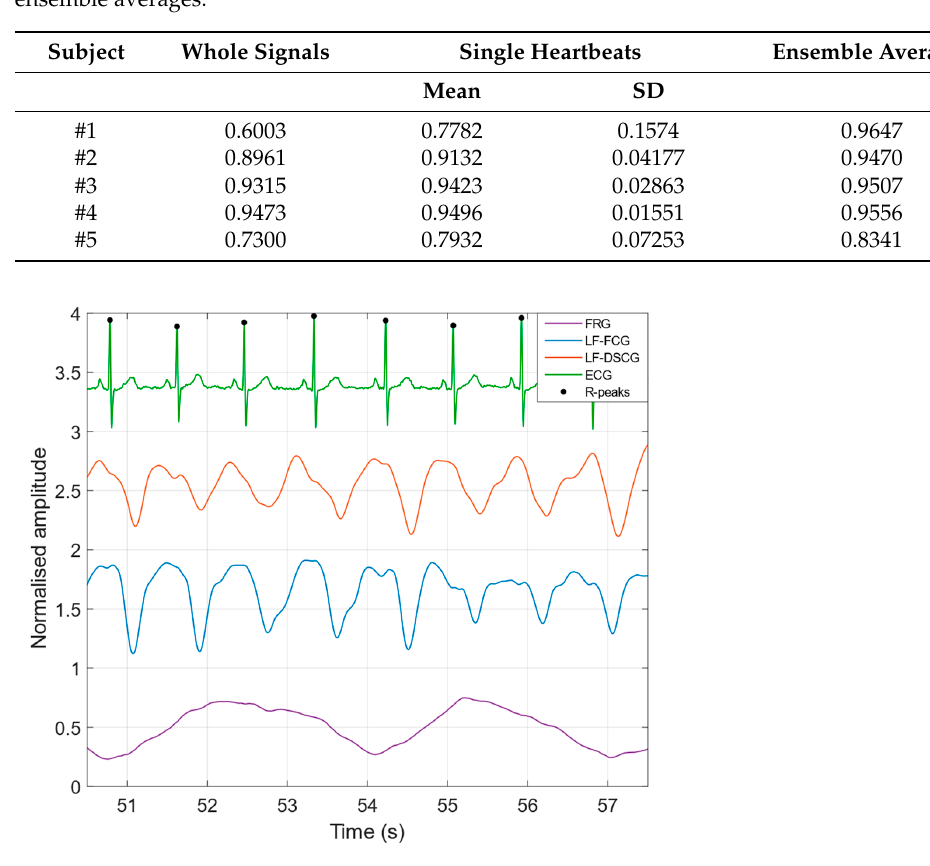
Figure 3. FRG, LF-FCG, LF-DSCG and ECG signals acquired during quiet breathing (subject #2). Table 2. Normalized cross-correlation indices between LF-FCG and LF-DSCG signals acquired dur- ing quiet breathing. The correlation indices were computed between the whole signals, between single corresponding heartbeats (mean and SD of correlation indices are reported) and between the ECG-triggered ensemble averages. Subject